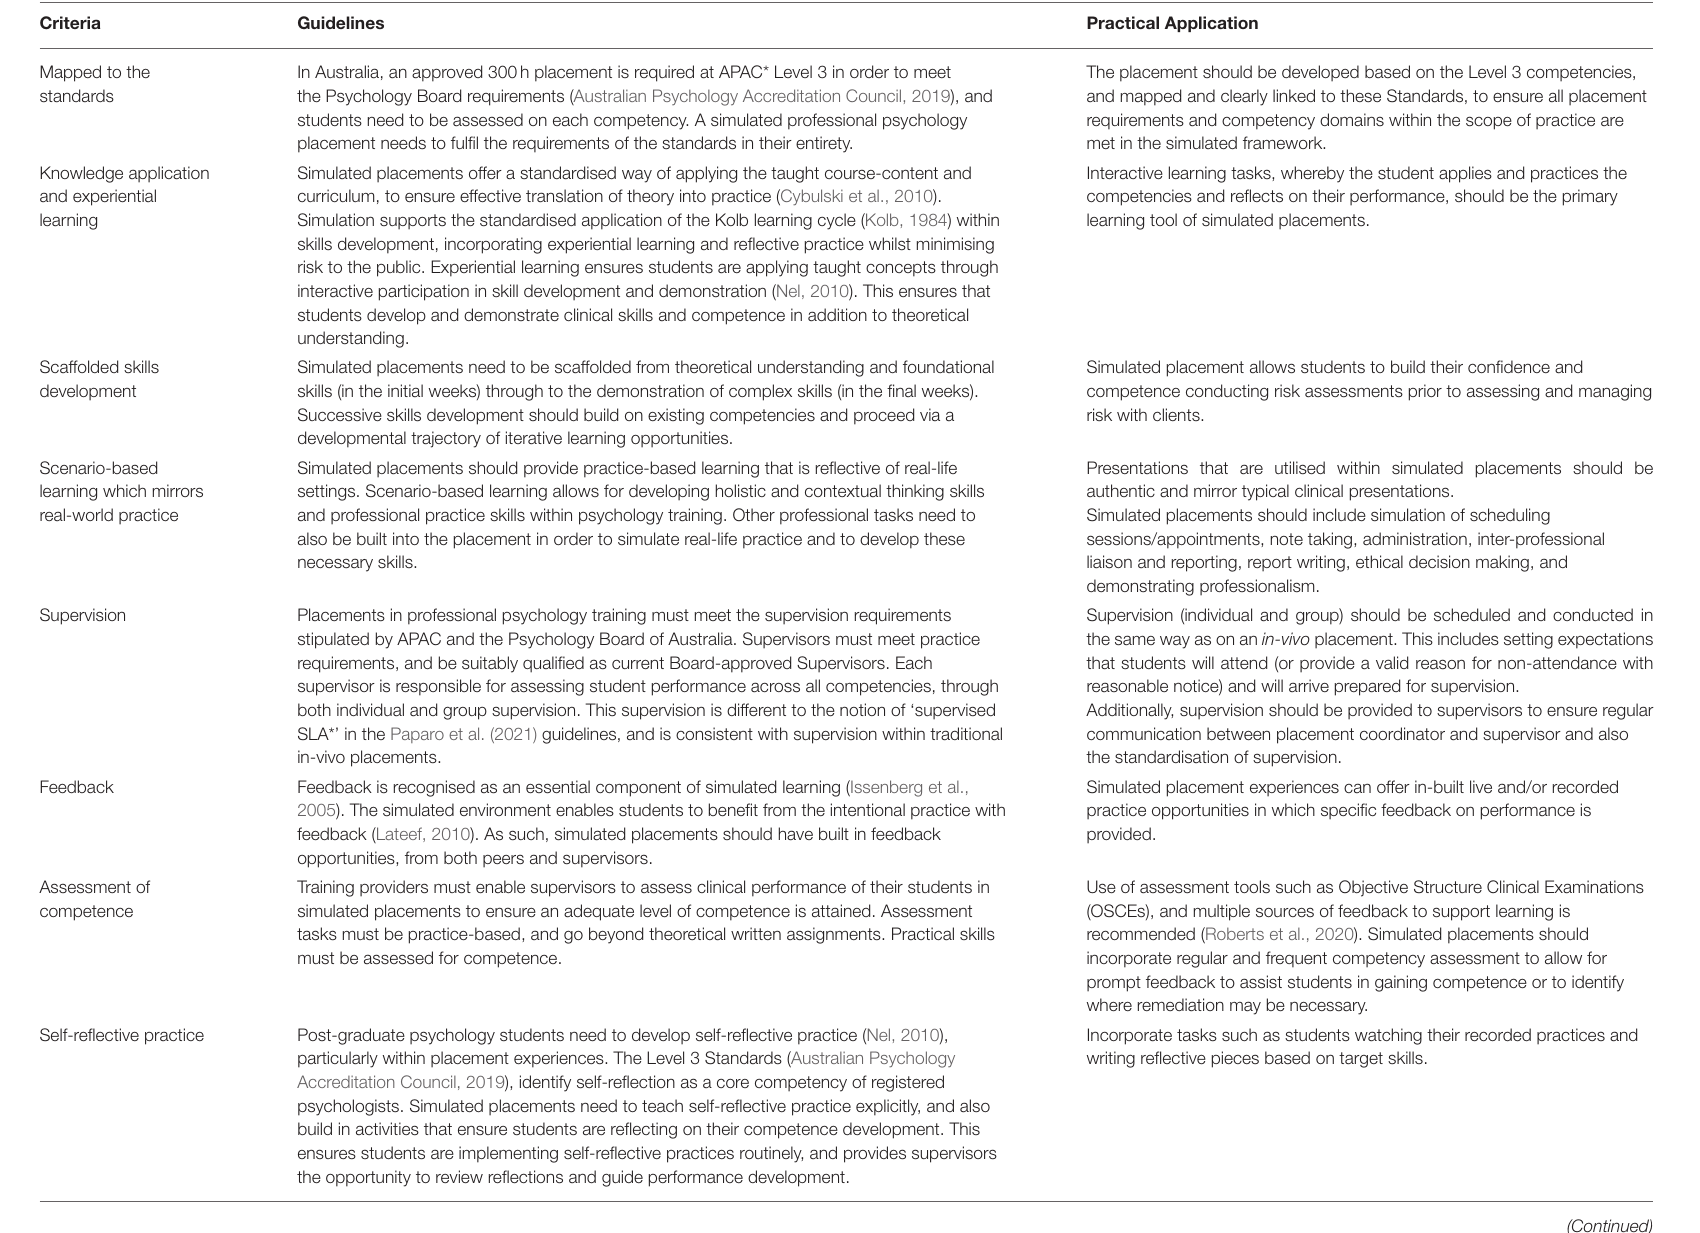
TABLE 1 | Guidelines for simulated learning specifically within professional psychology